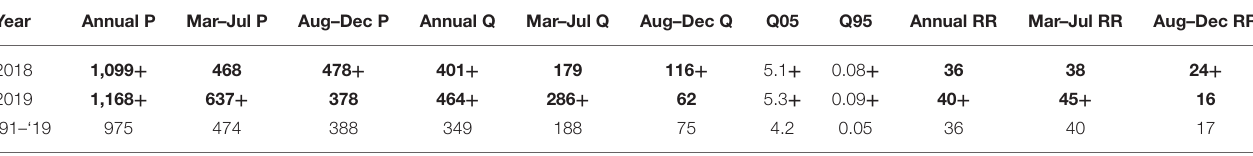
TABLE 2 | Mean precipitation (P) and runoff (Q) characteristics among the 16 watersheds for 2018, 2019, and the 1990–2019